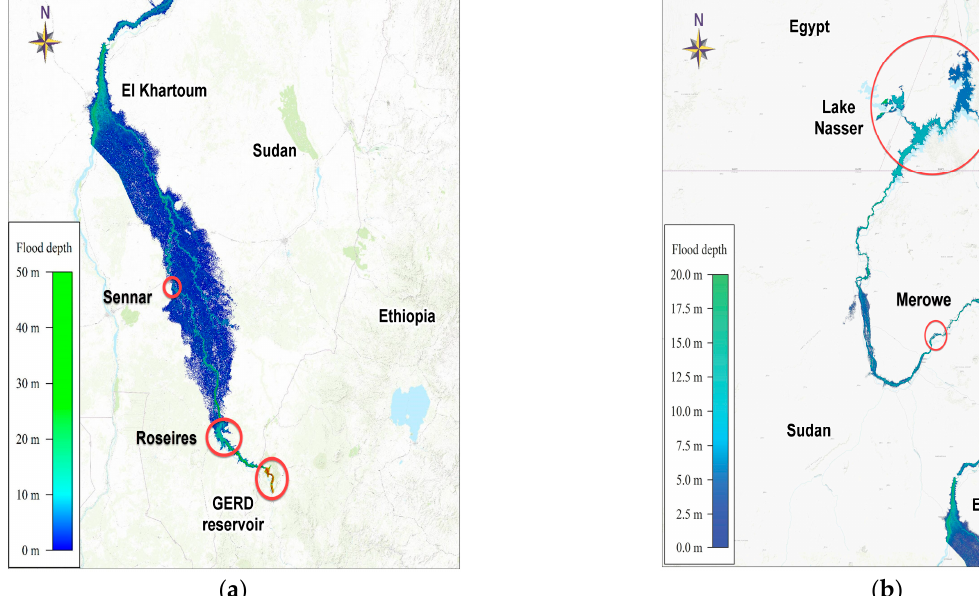
Figure 8. Maximum inundation depth: ( a ) GERD to Khartoum and ( b ) Khartoum to AHD.